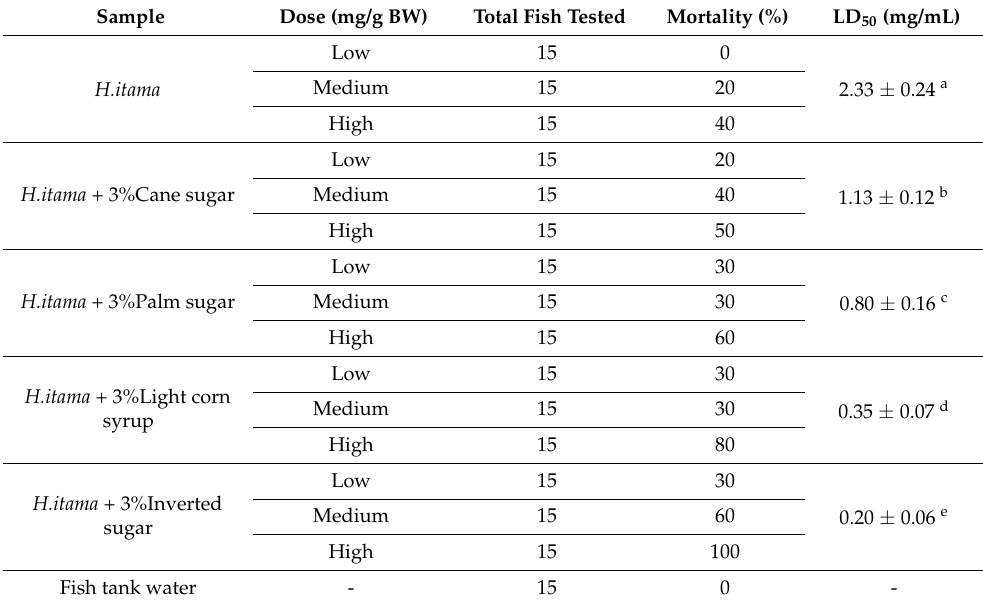
Table 5. Sub-acute toxicity test of pure and sugar adulterated H. itama honey in adult zebrafish ( Danio rerio ) after 14